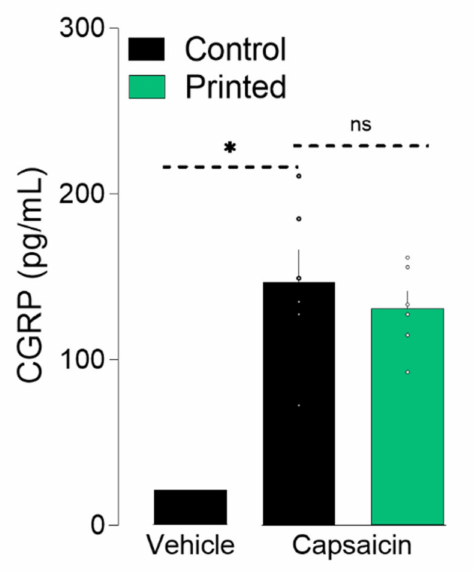
Figure 4. Printed-DRG neurons release neuropeptide. DRG neurons were printed and cultured for 48 h and exposed to capsaicin (1 uM). Supernatant was harvested 10 min after capsaicin exposure and CGRP release was measured by ELISA. Results consist of the means ± S.E.M. Individual values are represented with “ ◦ ”.One-way ANOVA with Tukey’s multi comparisons test. Significant differences are indicated by asterisks ( p < 0.05 = *; ns: not significant as u >